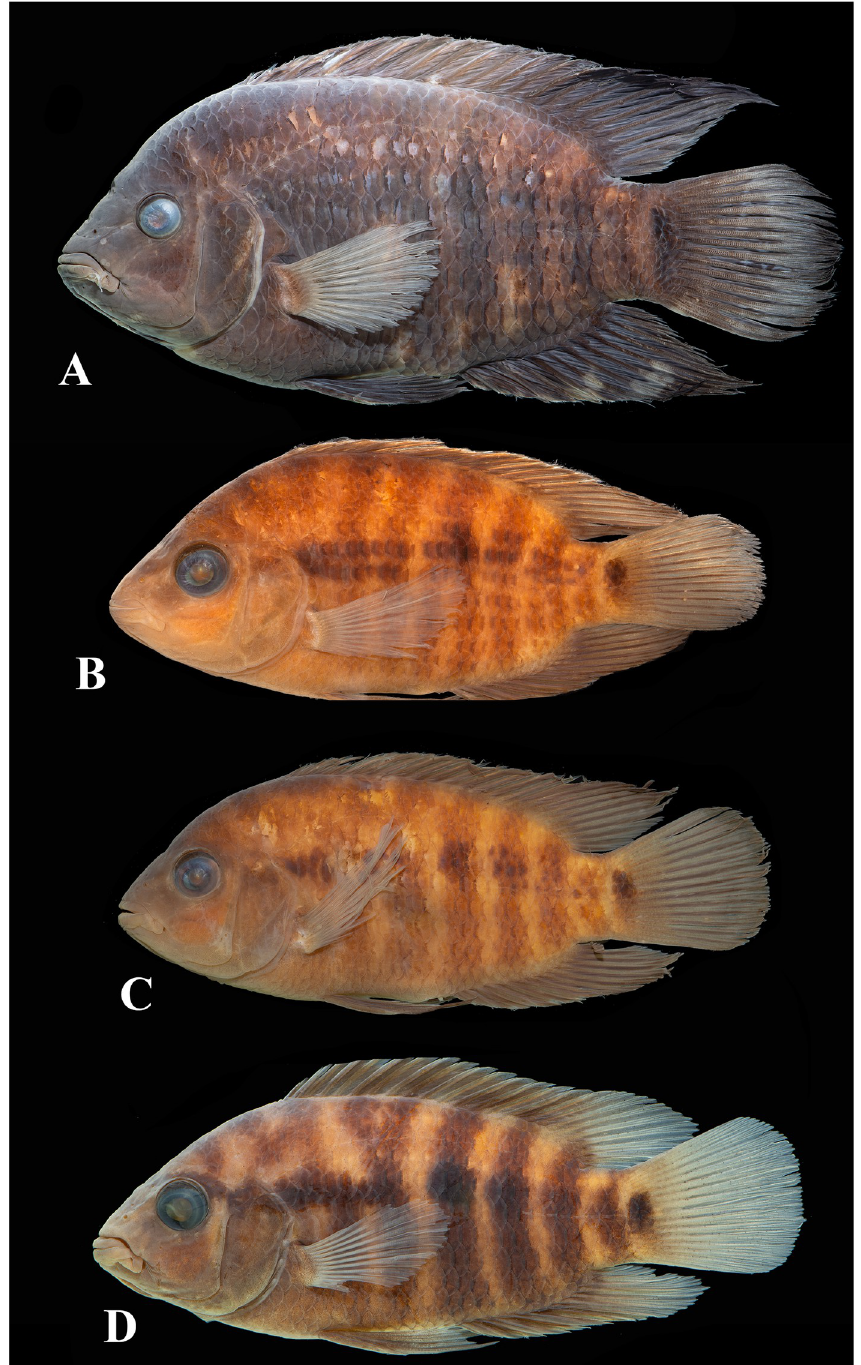
Fig 23. A . Australoheros sp., “Arapey”, adult female, 138.0 mm SL; NRM 52219; Uruguay: Salto: Rio Uruguay drainage,10 km from Valentin, below road 31 bridge, small stream within the Rio Arapey drainage . B Australoheros minuano , holotype, adult, not sexed, 70.8 mm SL; MCP 12710; Brazil, Rio Grande do Sul, Arroyo Canoin, Rio Uruguay drainage, road from Pirapo to S ã o Nicolau. C. Australoheros minuano , paratype, adult, not sexed, 83.9 mm SL. MCP 46757; Brazil, Rio Grande do Sul, Arroyo Canoin, Rio Uruguay drainage, road from Pirapo to S ã o Nicolau. D. Australoheros ribeirae , adult male, 63.4 mm SL; NUP 5514; Brazil: S ã o Paulo: Tapiraı´: Rio Ribeira de Iguape basin: Ribeir ã o do Prumo, tributary of Rio Verde, Sı´tio Uni ã o, bairro doCha´.